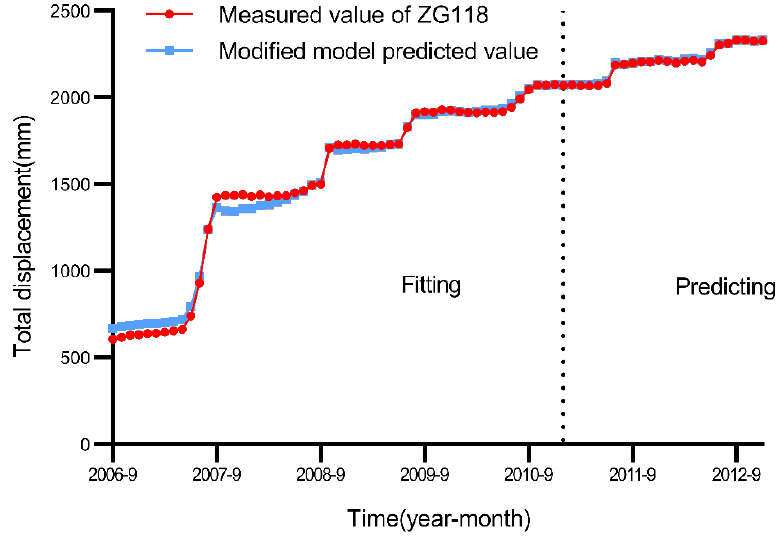
Figure 15. Fitting and predicting results of cumulative displacement of ZG118.